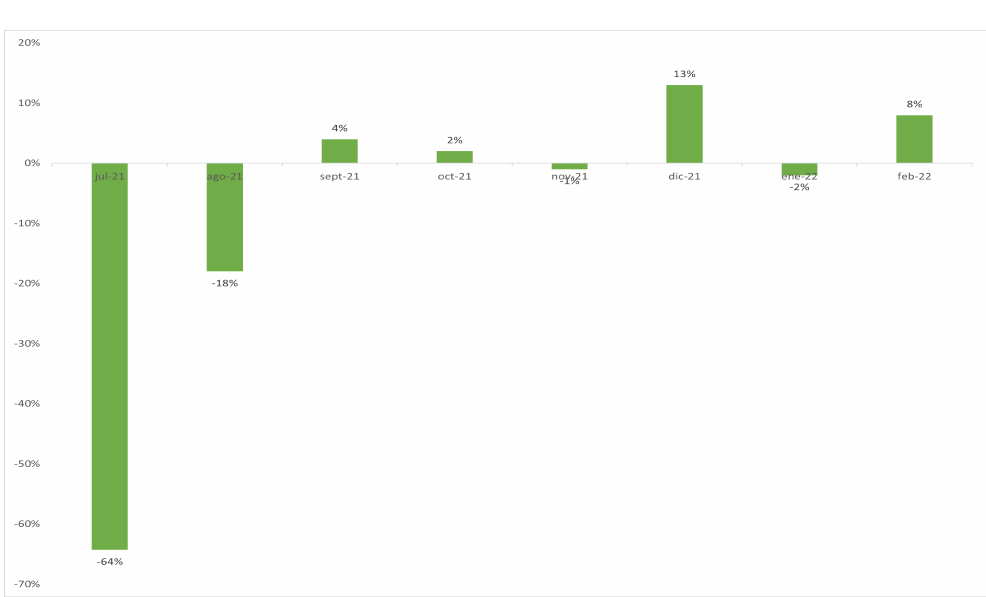
Figure 10. Sentiment distribution per month.